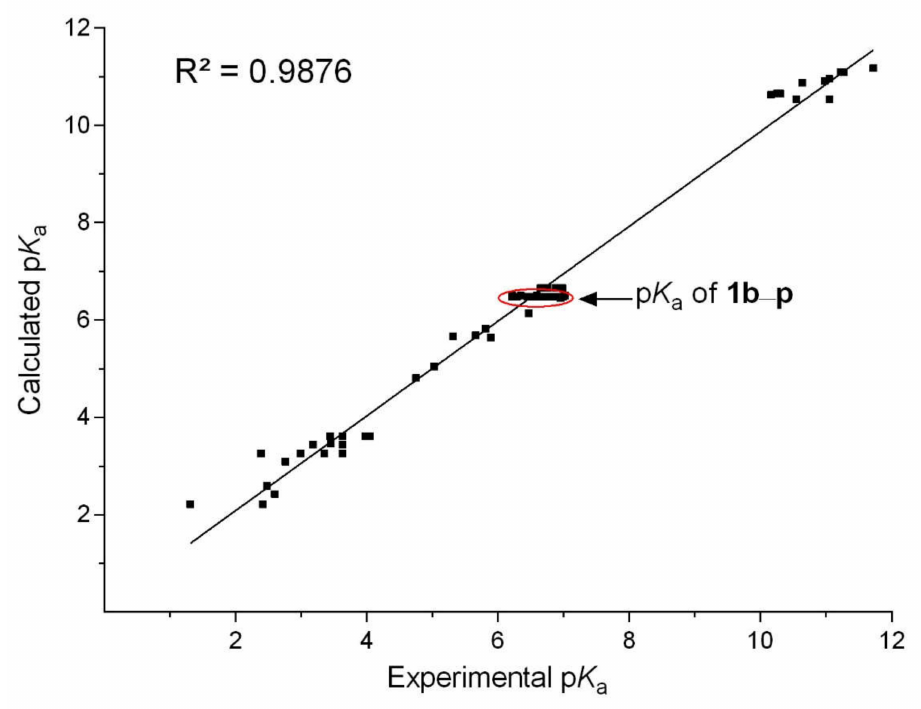
Figure 4. Correlation between experimental and calculated p K a values for a pooled database of 59 α - aminophosphonates using the updated linear predictive model of Equation (1) (see also Table S2). The red circle indicates the p K a domain of new compounds 1b – p